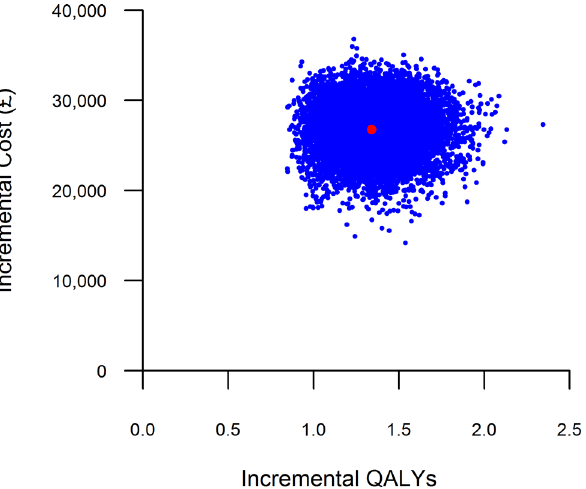
Fig 6. Scatter plot of probabilistic results (15-year horizon). The red dot represents the deterministic result.